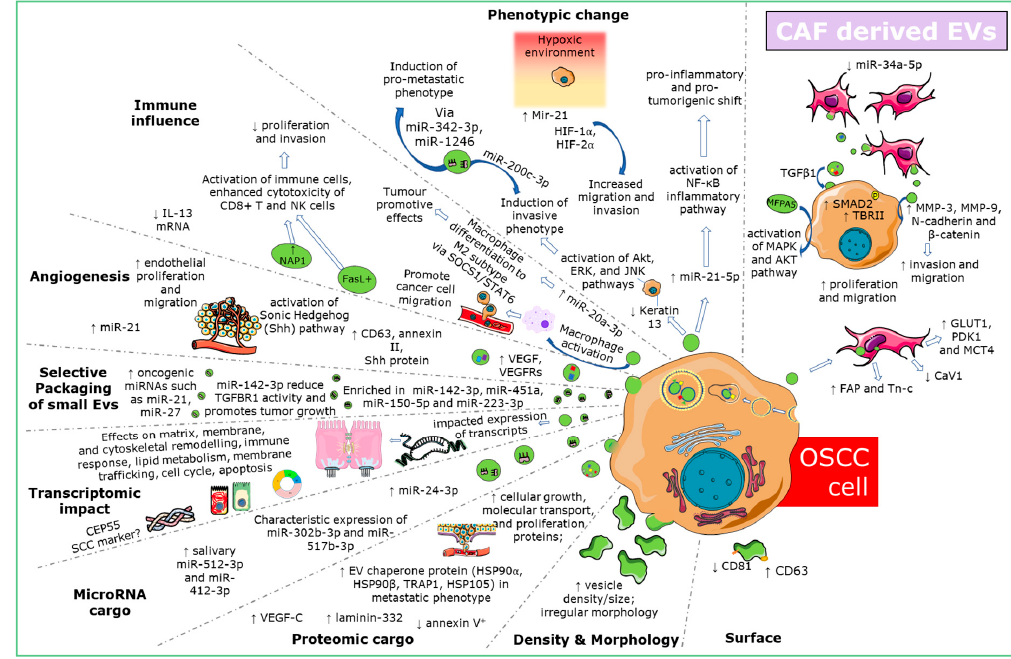
Figure 1. Known roles and interactions of EVs in OSCC.